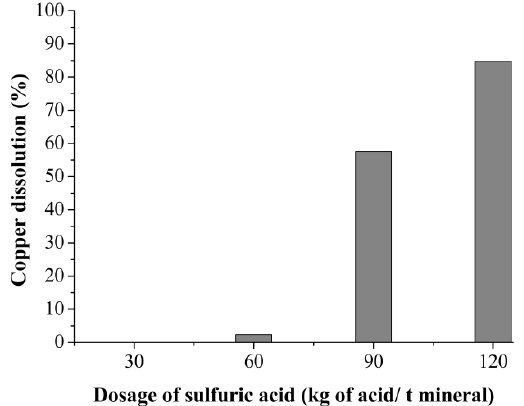
Figure 2. Curing test to evaluate the sulfuric acid dosage.